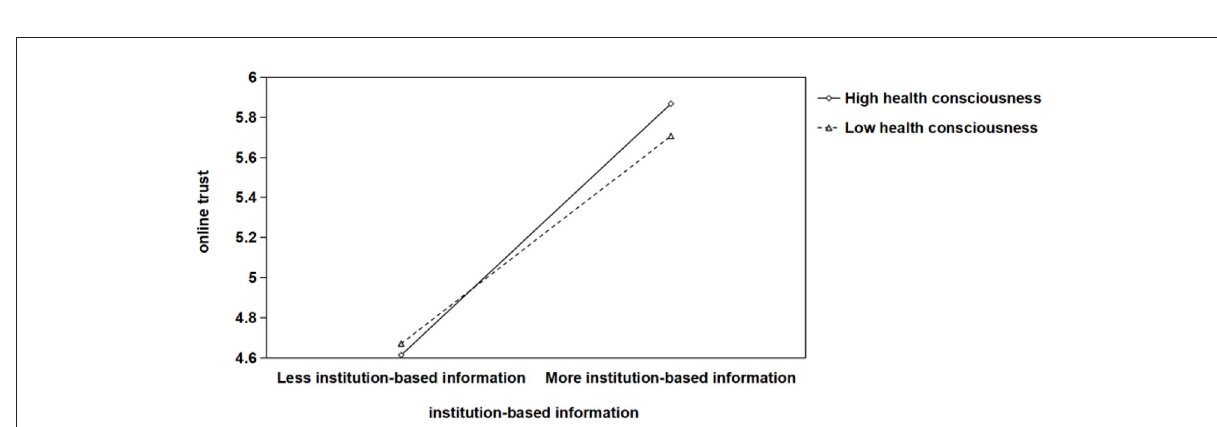
low [indirect effect = 0.214, 95% Boot CI = (0.146,